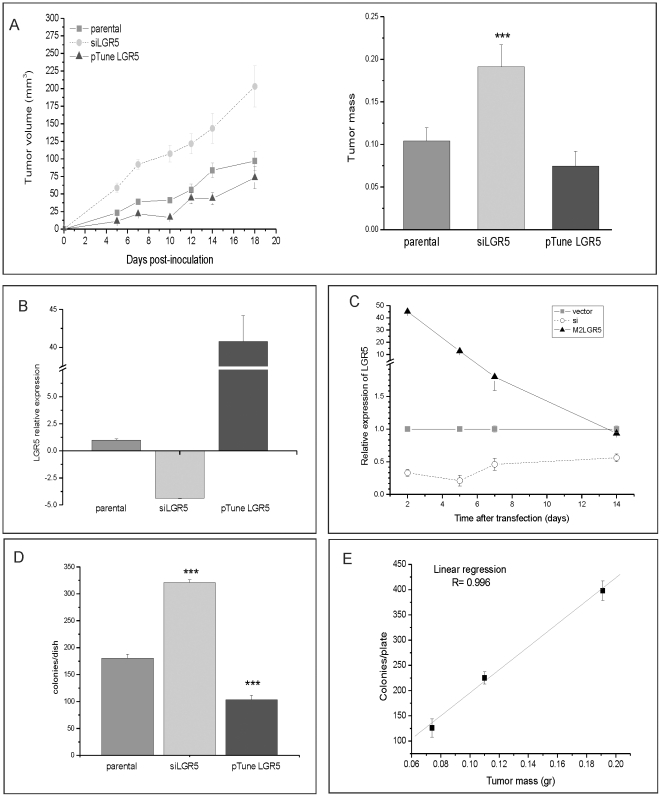
Xenograft tumour growth is affected by the levels of LGR5.LIM1899 cells were mock transfected (no vector), transfected with Cy3LGR5 or with pTune/LGR5. Cells were expanded for two doublings (48 hrs) after transfection, then collected for inoculation in nude mice, determination of growth in soft agar and measurement of LGR5 expression by qRT-PCR as described in Methods. A) Left panel: xenografts tumour growth curves, right panel: tumour mass at day18. The growth of subcutaneous tumours was measured three times weekly using callipers, and volume determined by the formula V = 1/2 (length×width2). At the end of the experiment (day 18) tumours were dissected and weighed. Data are averages and standard errors for each group (16 tumours/group). There was no statistical difference between parental and pTune Lgr5 tumour mass, however the difference between parental and siLGR5 tumours is significant (*** = p<0.001). B) A sample of cells used for xenograft injection was tested by qRT-PCR for LGR5 expression. Data were analysed in ABI 7300 (ΔΔCt study), and are presented as LGR5 expression relative to the parental cells. Data are presented as means and standard errors. C) Time course of transgene expression in cultured LIM 1899. The expression of LGR5 in cells transfected with siLGR5 or pTune LGR5 was followed over a period of two weeks by qRT-PCR. Levels of LGR5 expression are presented relative to vector control for each of the time points. D) A sample of cells used for the xenograft experiment was cultured in soft-agar plates at 5×103 cells/plate to determine cloning efficiency. Plates were incubated for 10 days, then stained with crystal violet and colony numbers determined by light microscopy. *** = p<0.001. E) Correlation between tumour mass (graph A) and cloning efficiency (graph D).